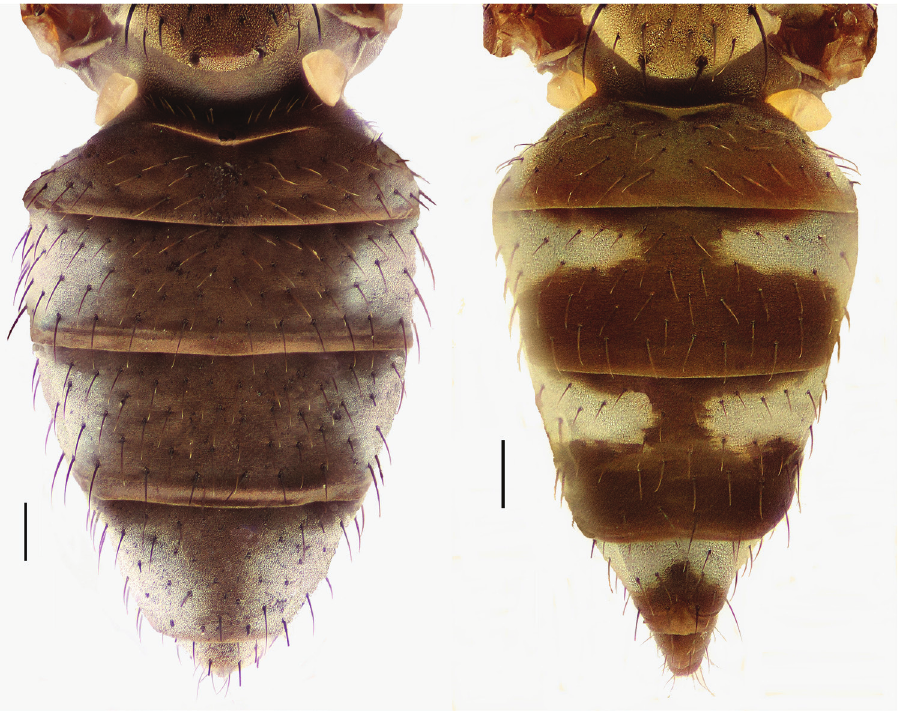
Figures 70–71. Abdomens of females, dorsal view. 70 Hydrochasma spinosum sp. n. (Costa Rica. Puntarenas: Dominical) 71 Hydrochasma denticum sp. n. (Ecuador. Orellana: Río Tiputini). Scale bar = 0.1